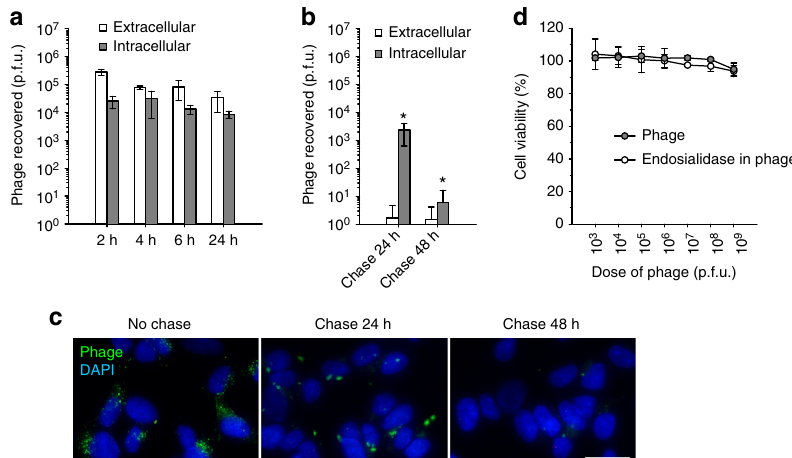
Fig. 5 Persistence and inactivation of internalized phage. a Recovery of internalized or cell surface bound PK1A2 phages from kSK-N-SH cells. Cells were incubated with phages at 37 °C for the times indicated. The amounts of extracellular and intracellular phages were determined and are shown as plaque- forming units (p.f.u.). Each bar represents the mean ± s.d. of three independent experiments. b Inactivation of internalized phages in the cells. Cells were pulsed with phages for 24 h at 37 °C, after which extracellular phages were removed by polysialic acid competition (last column in a ). Subsequently, the phages were chased with cell medium without phages for the times indicated. Phage quantitation results are expressed as mean ± s.d. of three independent experiments. The asterisks mark P -value of < 0.03 (compared to last column in a ) as calculated by Student ’ s t -test. c Visualization of phages in pulse-chase experiment. Cells were pulsed with FITC-labeled phages (green) and chased with phage-free cell medium as in a and b , respectively. Nuclei were stained with DAPI (blue). Representative images from two biological replicates are shown. The scale bar represents 20 µ m. d Absence of cellular cytotoxicity of phage. kSK-N-SH cells were incubated with increasing doses of phage or endosialidase-containing control phage in the growth medium for 24 h and subjected to cell viability assay. The data represent the mean ± s.d. of three independent experiments including two technical replicates